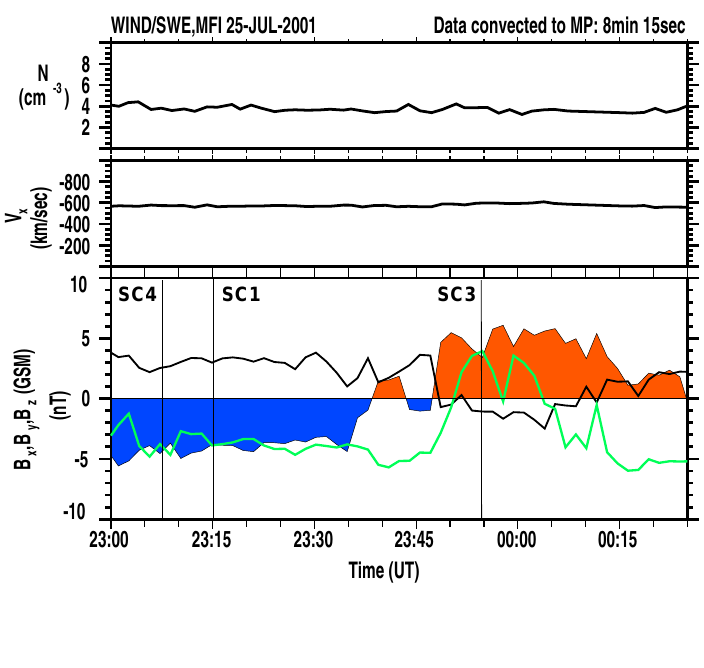
Fig. 1. Solar wind parameter mea- surements by Wind/SWE, MFI on 25 July 2001. The data have been prop- agated by about 8min, to account for the travel time from the Wind spacecraft to the magnetopause. Plotted are so- lar wind density N , solar wind velocity V x and the magnetic field components B x (black line), B y (green line) and B z (shaded area). Vertical black lines in- dicate the times when Cluster satellites crossed into the cusp, to illustrate the temporal separation of the